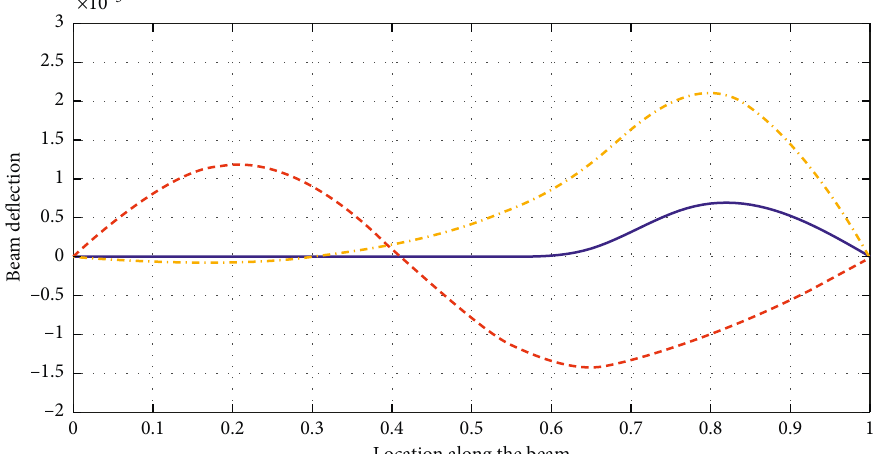
� 0 . 3, x � 0 . 4, x � 0 . 6, and x � 0 . 7. The inset shows the detailed plot of the controlled a 1 a 2 s 1 s 2